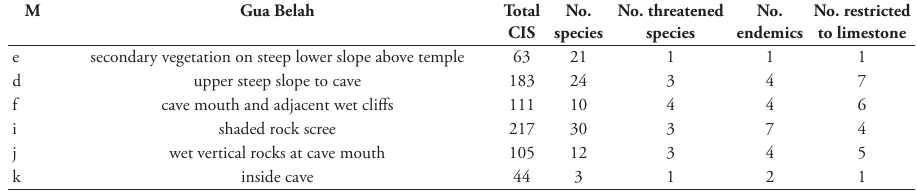
No. No. threatened No. No. restricted CIS species species endemics to limestone